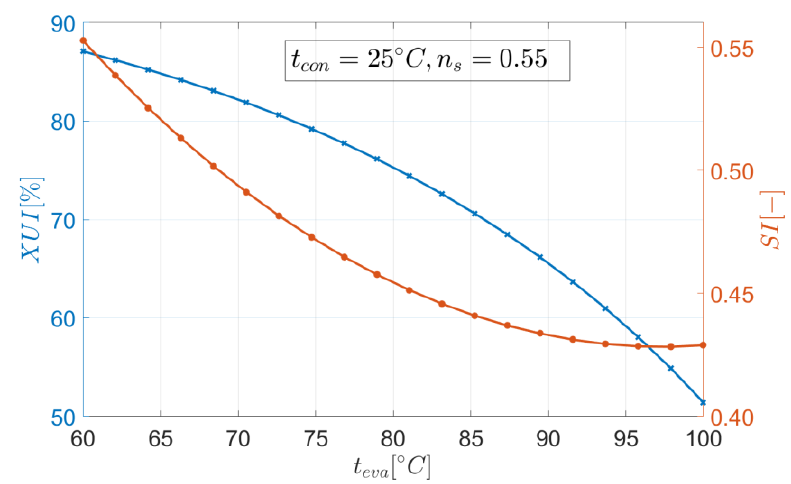
Figure 8. XUI and SI index as functions of evaporation temperature t eva .